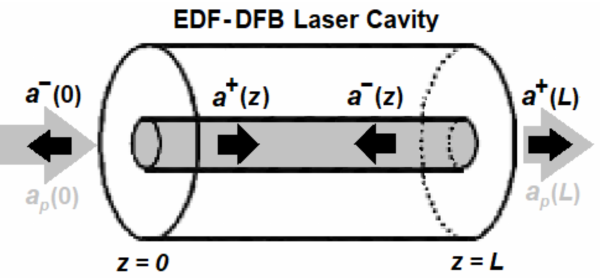
Figure 1. Schematic of propagating pump and signal in an EDF-DFB laser with an FBG cavity length of L . a p and ( a + , a − ) are the pump and signal amplitudes,